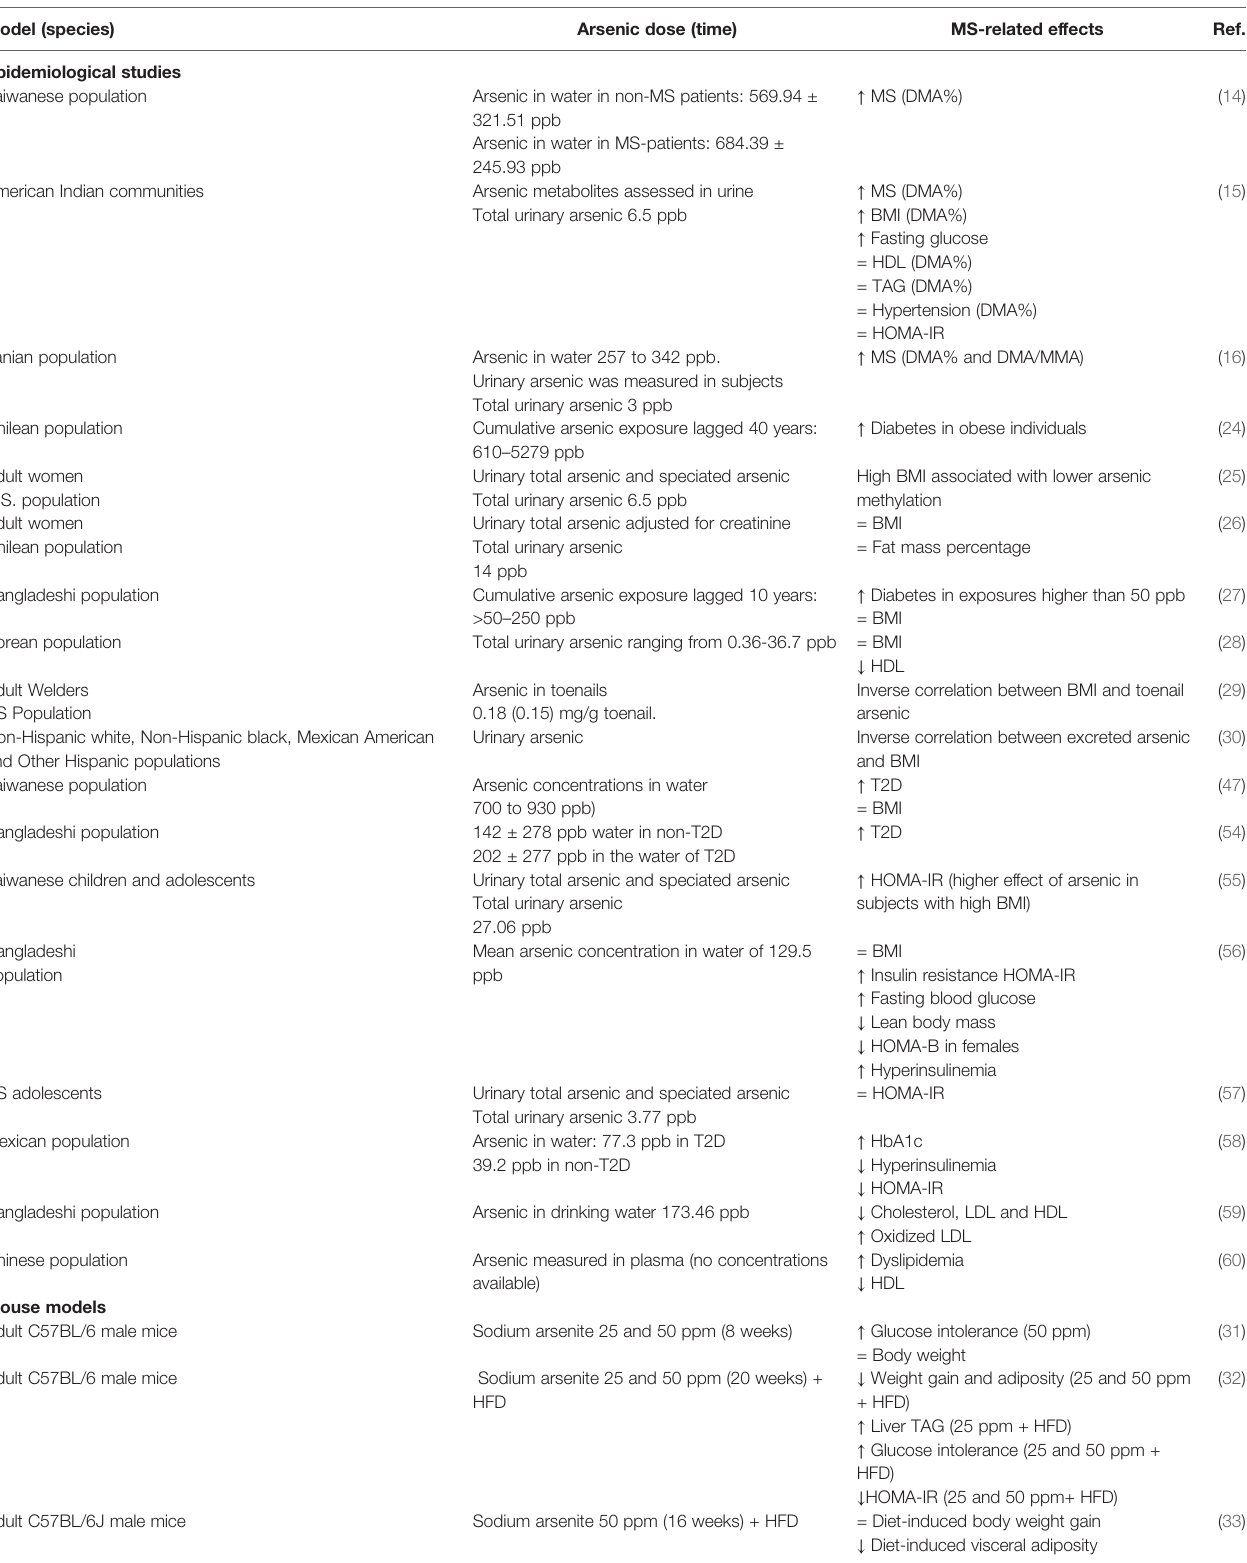
TABLE 1 | Comparison of arsenic exposure effects on the signs of MS between epidemiological studies and animal